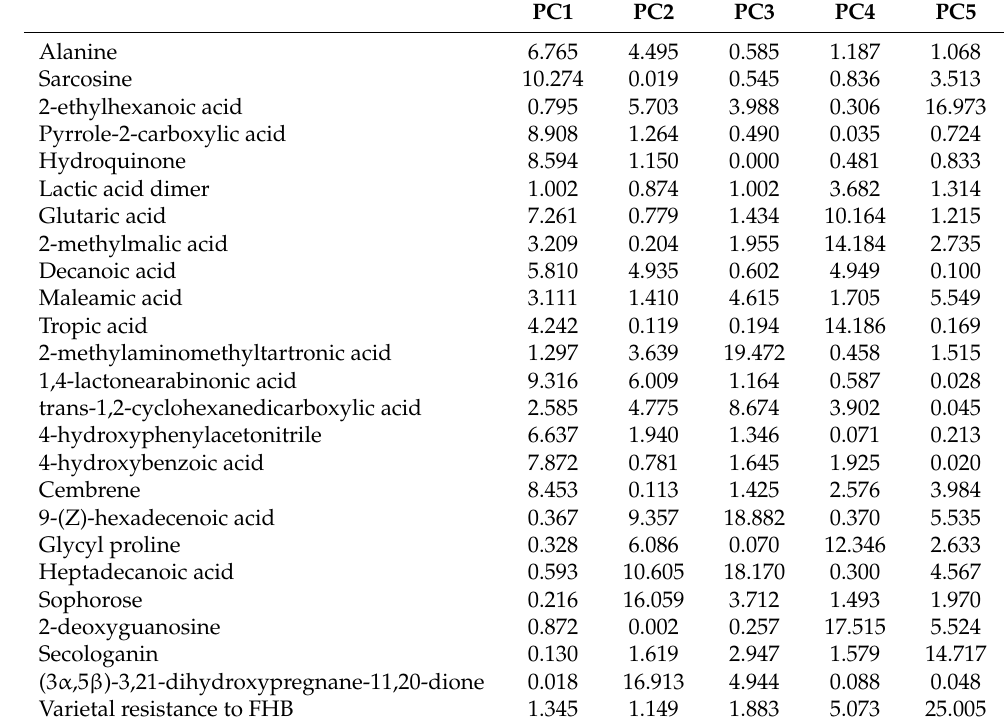
Table 2. The contributions (in percentage) of the variables to the principal components at both